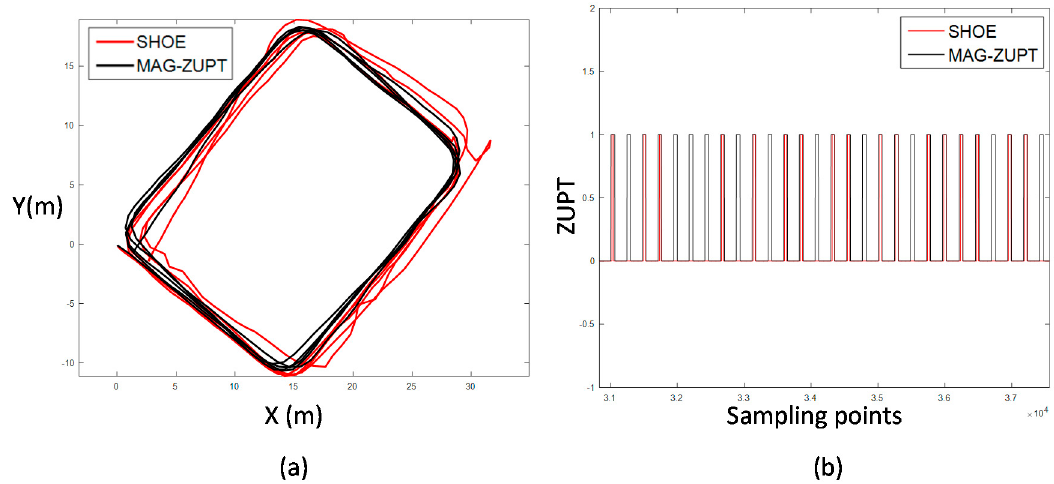
Figure 30. Positioning and ZUPT result of traditional ZUPT and mag-ZUPT of Traj_3; ( a ) is the positioning result. The trajectory of mag-ZUPT is more matched to the true trajectory; ( b ) is ZUPT information. Mag-ZUPT based stance phase estimation has a better performance. TTDE of this test is 0.39%.